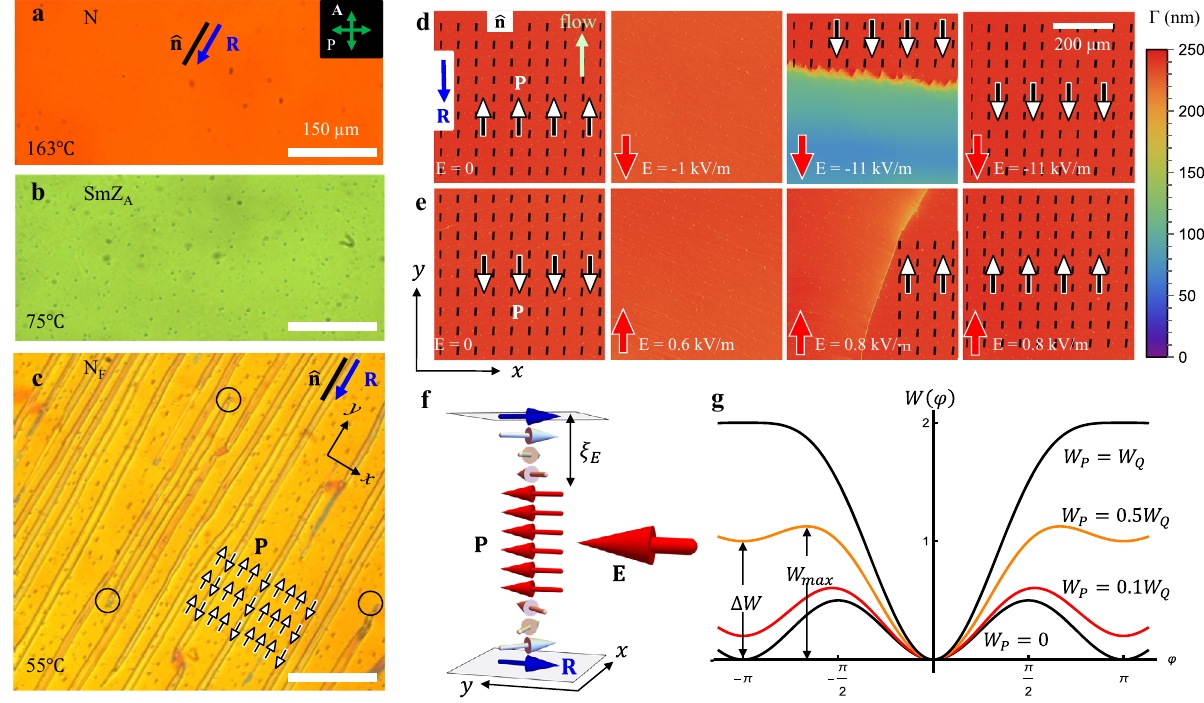
Fig. 1 DIO textures in planar cells with parallel assembly. a – c Polarizing optical microscopy of a thick d = 4.7 μ m sample and d , e PolScope Microimager textures of a thin 1.35 μ m sample. a , b Uniform N and SmZ A textures, respectively. c polydomain N F texture; the polarization P is antiparallel to the rubbing direction R in the wider domains and is parallel to R in the narrower domains; two 180° DWs enclosing the narrow domain reconnect (circles mark some reconnection points). d Field-induced realignment of P from the direction − R to R . e Reversed fi eld polarity realigns P back into the ground state P ↑↓ R . f Scheme of P reorientation in ( e ); there are two 180 o twist DWs of the Bloch type near the plates. g Azimuthal surface anchoring potential for different ratios of the polar W P and apolar W Q coef fi